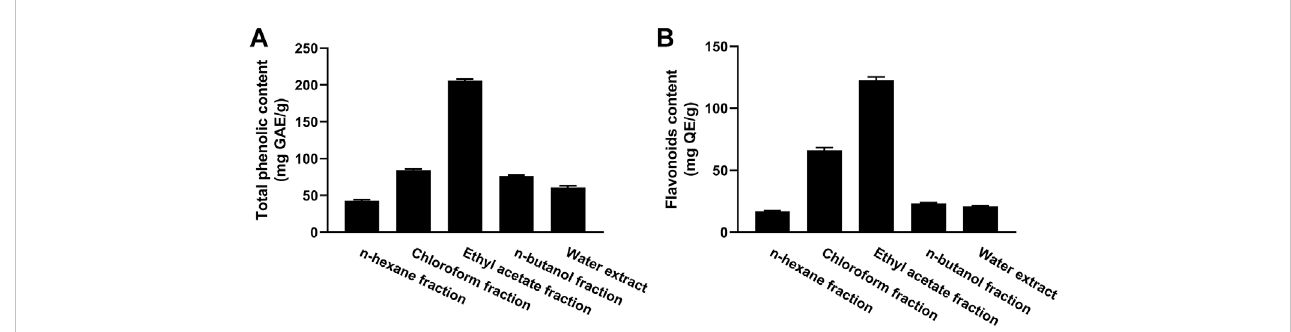
FIGURE 2 Total phenolic (A) and fl avonoid (B) content of different fractions of MEACL. Data are Mean ± SEM ( n =